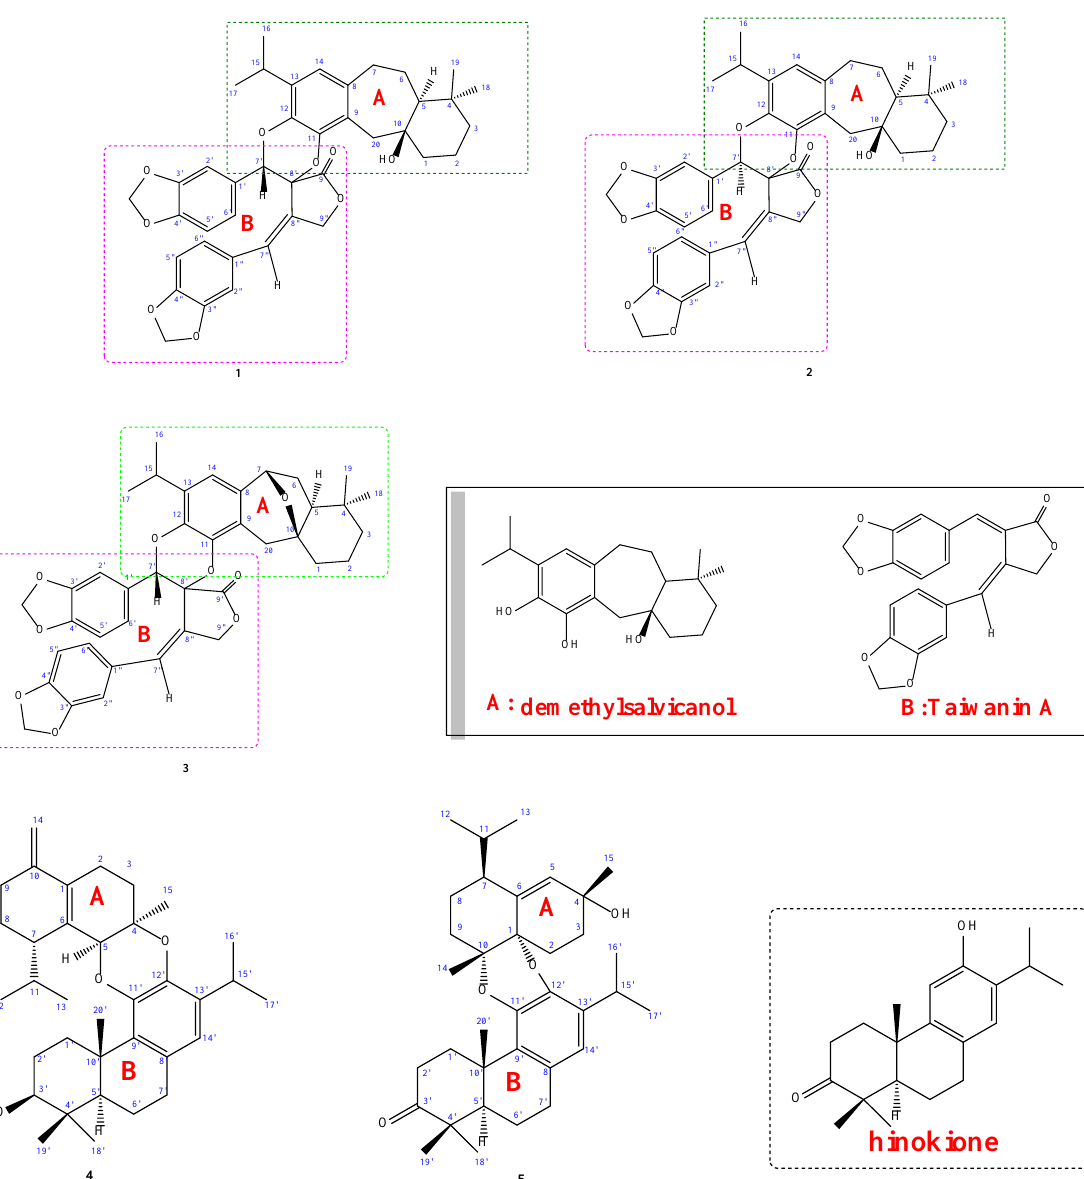
8′ and C-11 linkage of the two monomers in 1 was through a O -linkage functionality; judged by calculating the degree of unsaturation, subtracting the above inferred parts A and B, there is still one degree of unsaturation. Its molecular formula contains nine oxygen of unsaturation. Its molecular formula contains nine oxygen atoms and the downfield shift atoms and the downfield shift of H- 7′ (δ H 5.06) in constituent monomer-1, compared to of H-7 (cid:48) ( δ H 5.06) in constituent monomer-1, compared to that of the Taiwanin A analogues. that of the Taiwanin A analogues.